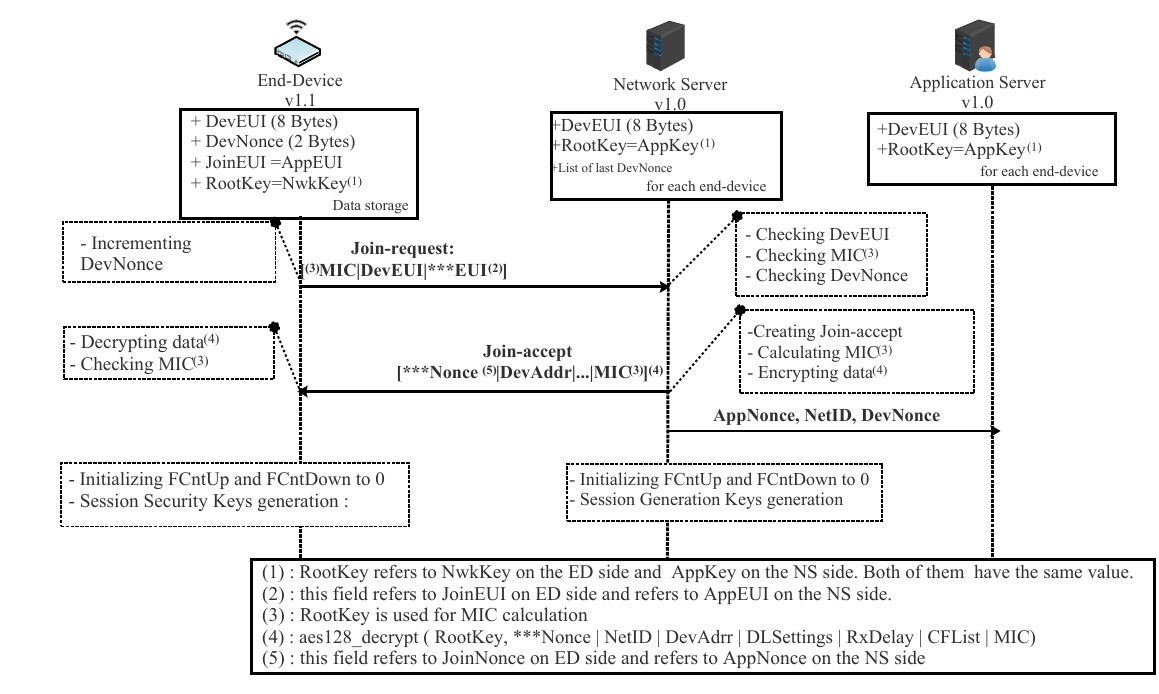
Figure 11. OTA-ED v1.1 joining NS v1.0 in scenario